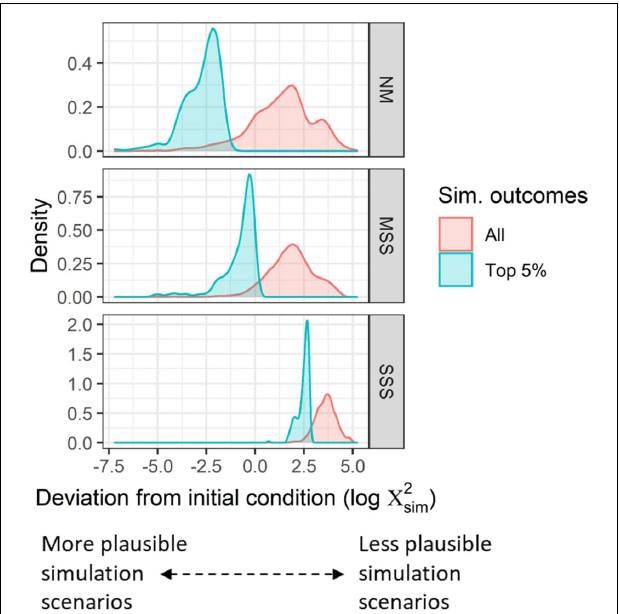
FIGURE 5 | Distribution of χ 2 sim scores (measurements of simulation deviation from initial condition) ( x -axis) for all simulations (red) and the top 5% most plausible simulations (blue) for each metacommunity type: neutral model (NM, top ), moderate species sorting (MSS, middle ), and strong species sorting (SSS, bottom ).